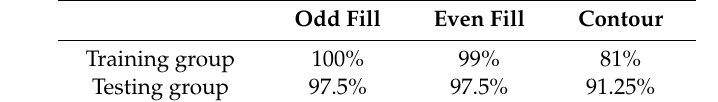
Table 4. The results of states identification using multiple features for both training group and testing group.